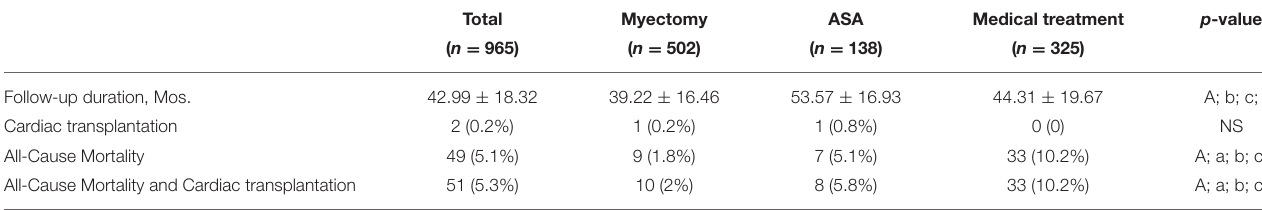
TABLE 3 | Clinical outcome. Total Myectomy ASA Medical treatment p -value ( n = 965) ( n = 502) ( n = 138) ( n = 325) Follow-up duration, Mos.